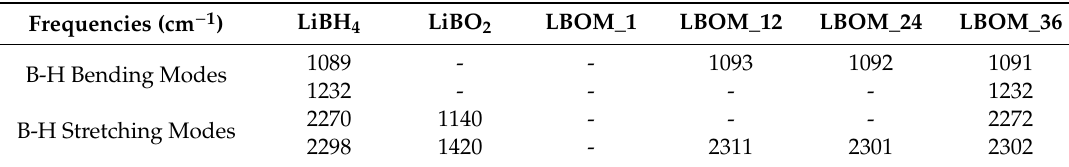
Table 4. Infrared vibration bands of LiBH 4 , LiBO 2 , and ball-milled materials at di ff erent milling time durations at room